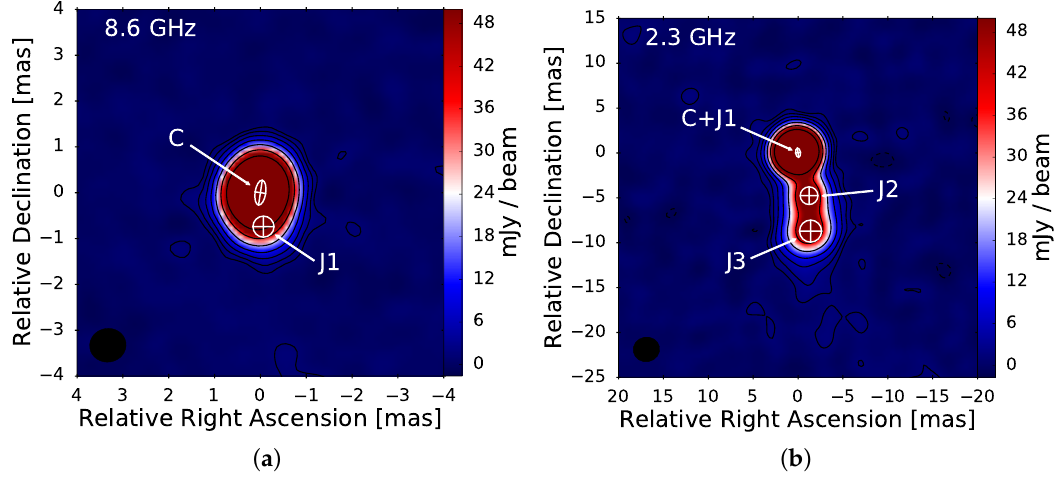
Figure 1. Pair of typical very long baseline interferometry (VLBI) images of the source J0017+8135. The images were taken in October 1998 at 8.6 GHz ( a ) and 2.3 GHz ( b ). The lowest contours correspond to 1% of the peak brightness, the positive contours increase by a factor of 2. The white circles are centered at the positions of the fitted Gaussian model components. Their radius corresponds to the full-width-at-half-maximum diameter of the given component. The restoring beam is indicated in the lower-left